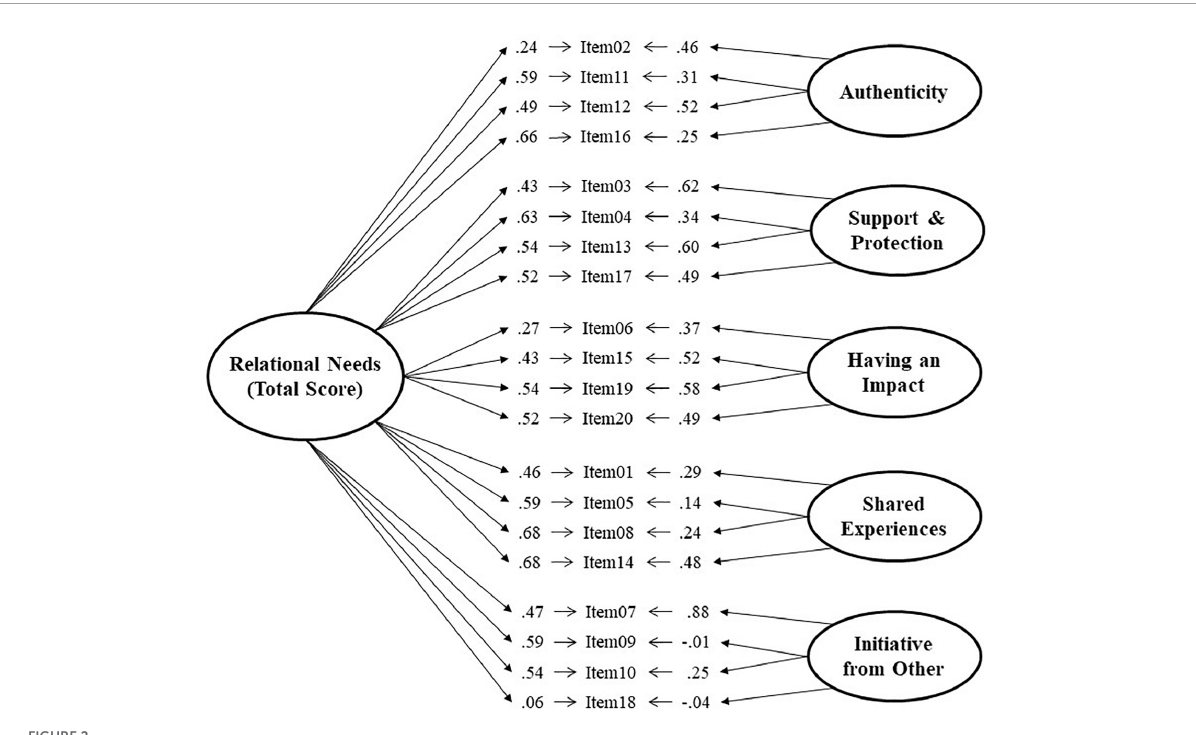
FIGURE2 Bi-factor model of